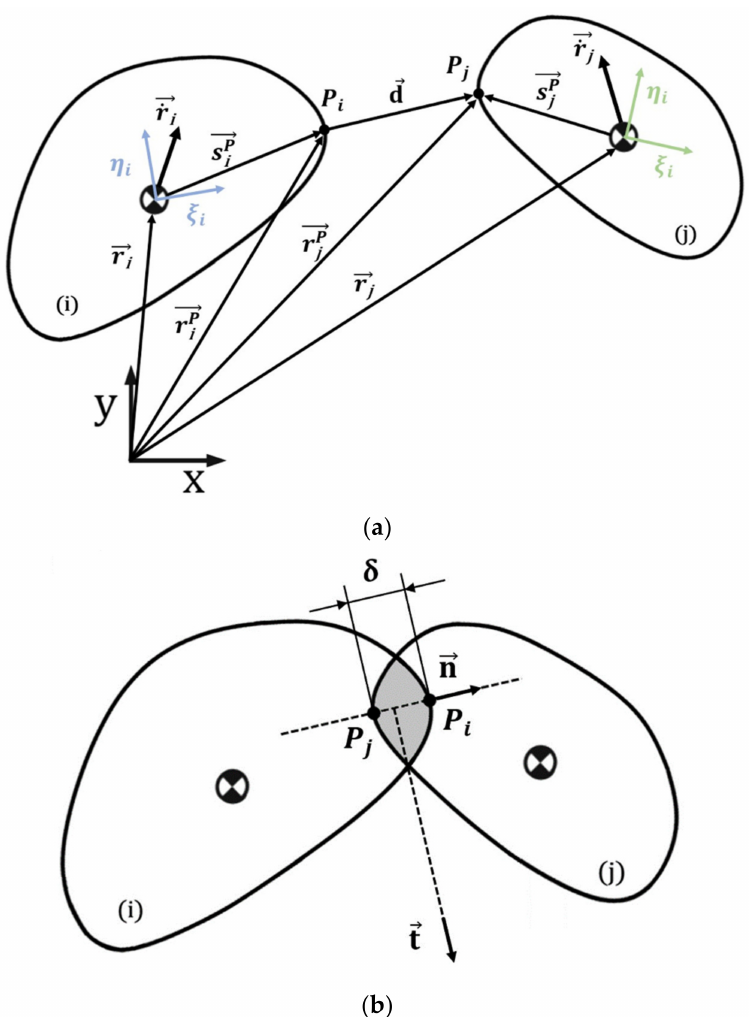
Figure 1. ( a ) General bodies with respect to the global reference system; ( b ) same bodies, with relative penetration. Both figures are presented in a 2D frame for ease of